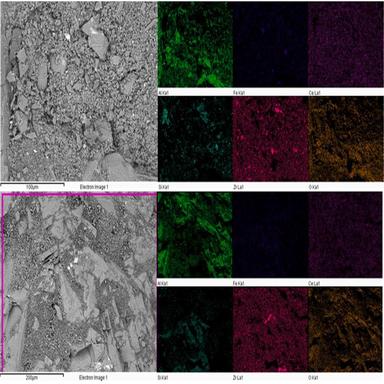
The qualitative analysis using SEM-EDS of the Top Surface layer of the stratified melt pool.